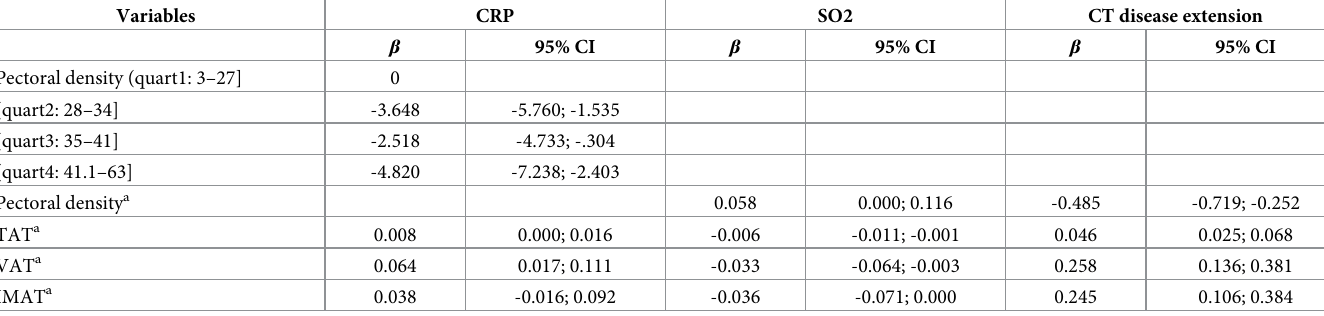
Multivariate linear regression models adjusted for sex, age and calendar period depicting the associations between pectoral density, TAT, VAT, and IMAT with disease severity at ER presentation described by CRP, SO2, and CT extension. TAT, total adipose tissue area; VAT, visceral adipose tissue area; IMAT, intermuscular adipose tissue area tissue area; ER, Emergency room; CRP, C-reactive protein; SO2, oxygen saturation level. a for unit